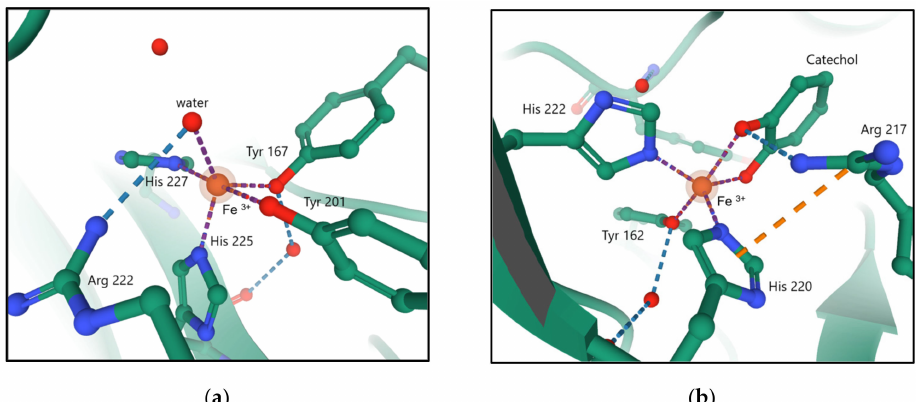
Figure 2. The active center of 1,2-CD with a coordinated water molecule ( a ) [PDB–2XSR] [14] as compared to the active 1,2-CD site that coordinates the catechol molecule ( b ) [PDB–3HHY]